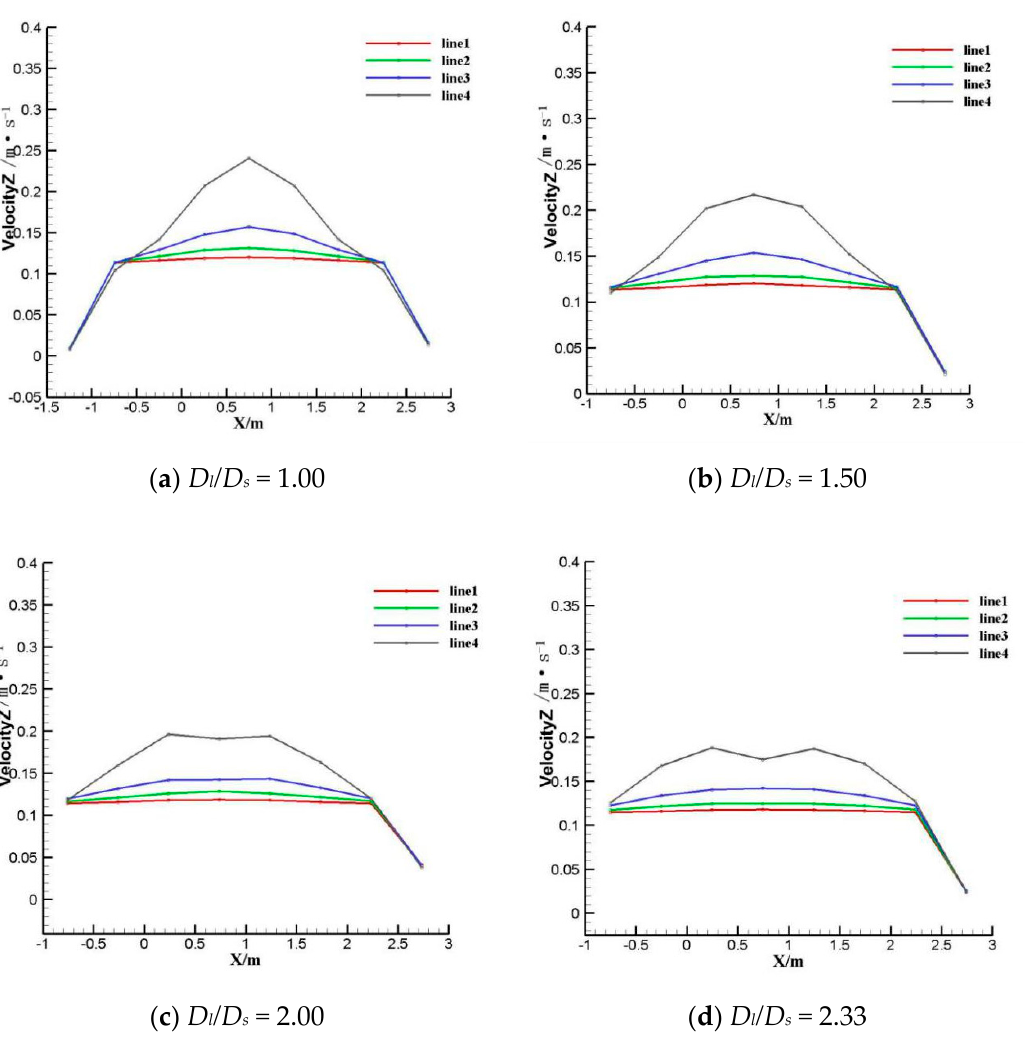
Figure 23. Suction sump multi-axis on the axial flow velocity distribution with different arrangement spacing.